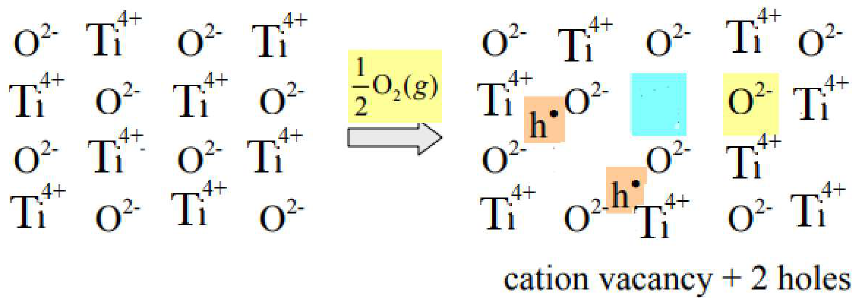
Figure 3. Electron-hole formation mechanism.